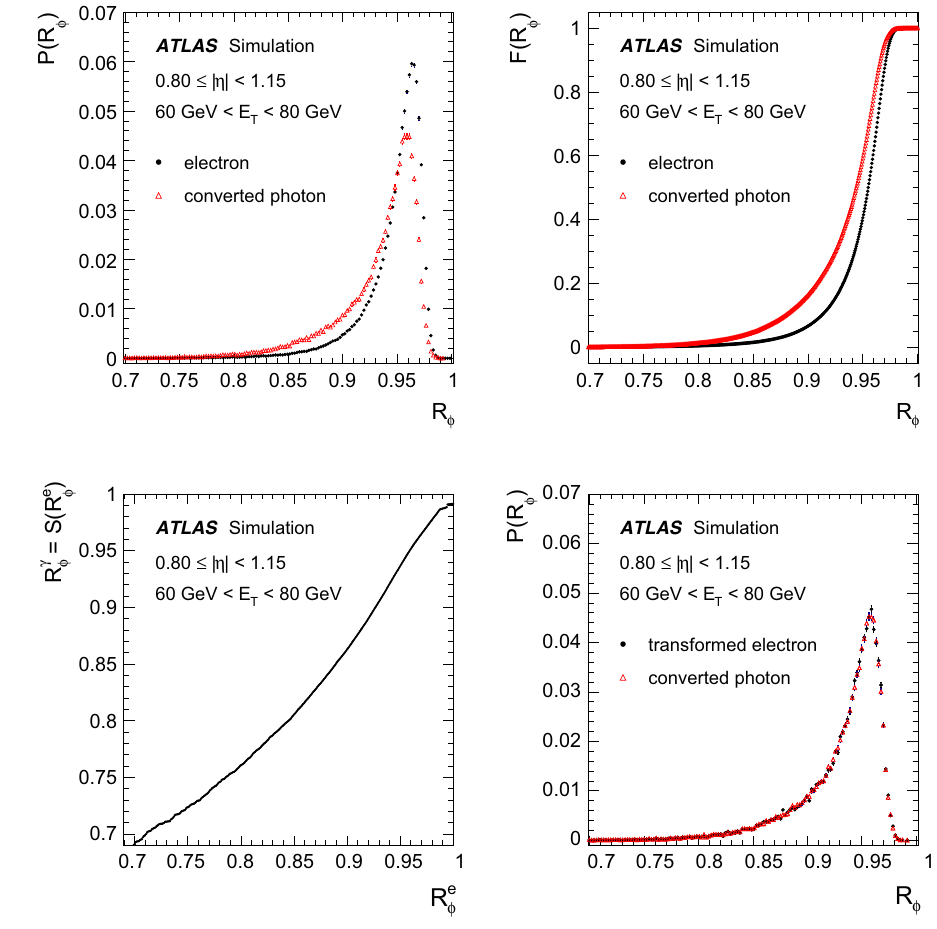
Fig. 5 Illustration of the Smirnov transform technique applied to photon and electron shower shapes. R φ is chosen as an example of a shower shape which differs notably between electrons and photons. The R φ distribution in each sample (top left) is used to calculate the corresponding cumulative distributions (top right). From the two cumulative distributions, a Smirnov transformation can be derived (bottom left). Applying the transformation leads to an R φ distribution which closely matches the photon